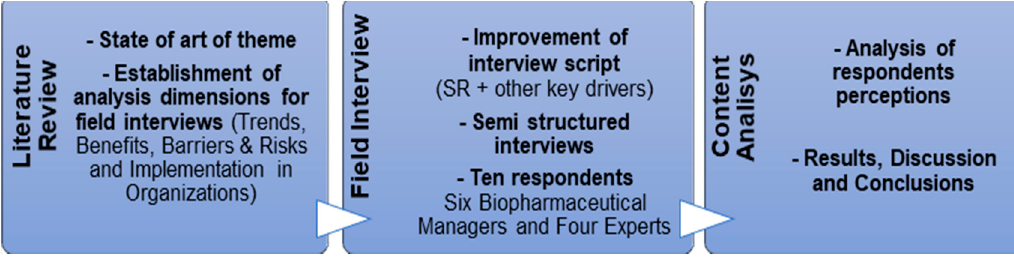
Figure 2. Methodological planning.